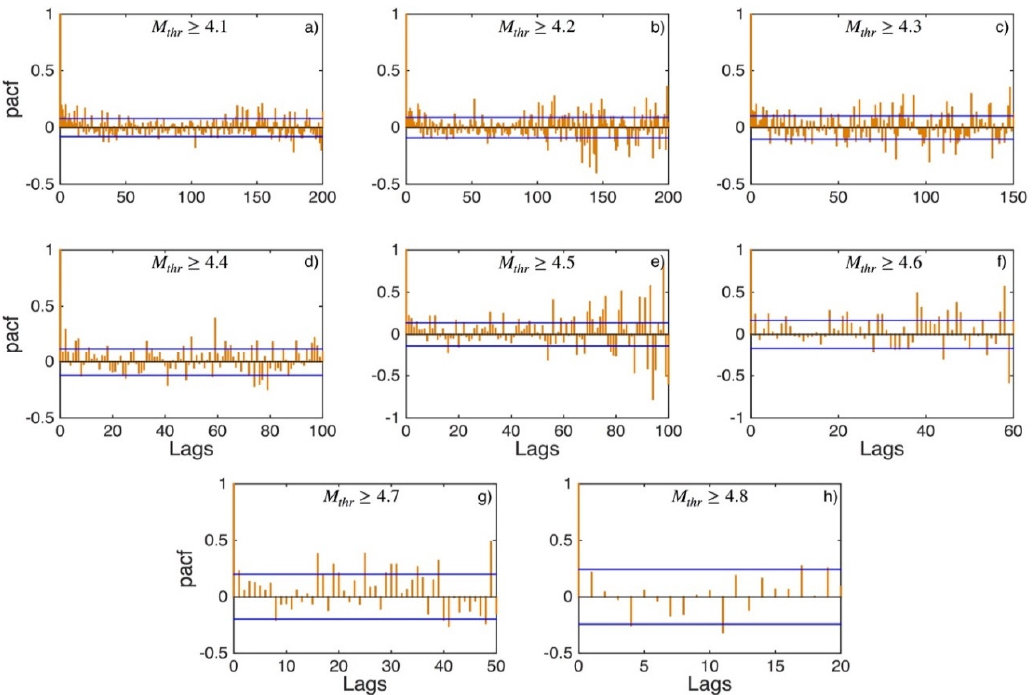
Figure A25. ACF values (red stems) and their 95% confidence intervals (blue lines) for Northern Greece and Balkans (sub − area 10) for magnitude thresholds ( M thr ) varying from 4.1 to 4.8 (subplots a – h ).